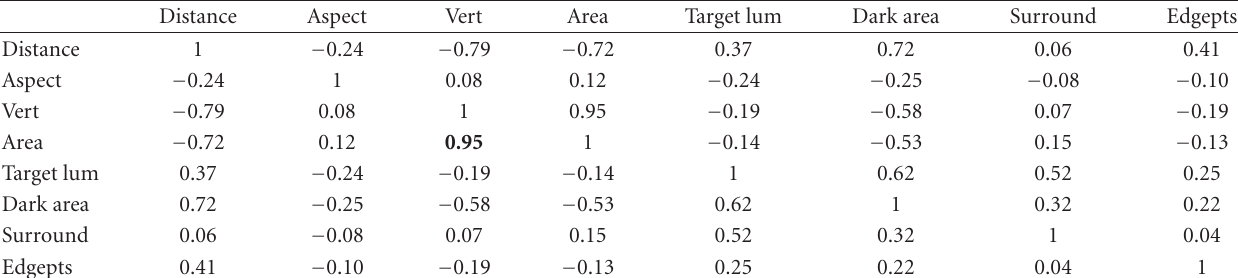
Table 2: Reproduced from [1]. Verimax analysis using MiniTab tool to calculate covariance between input vectors.